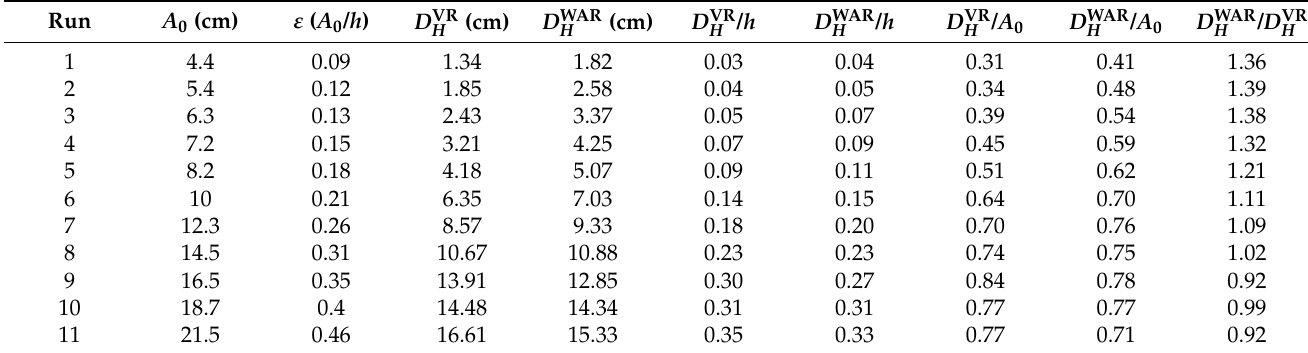
Table A2. Maximum inundation heights at WG3 ( x / h = 0.21).